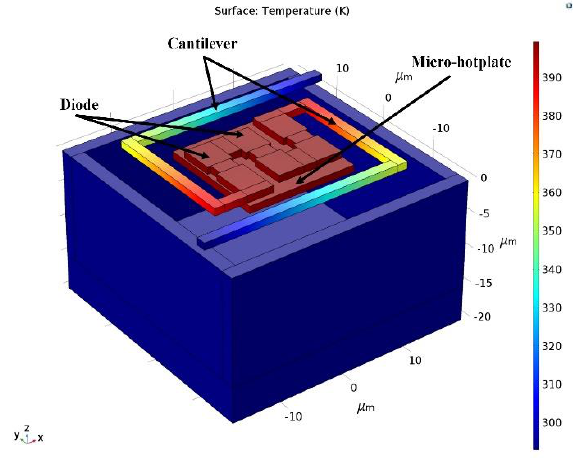
Figure 6. Temperature variation distribution of the micro-Pirani vacuum sensor.